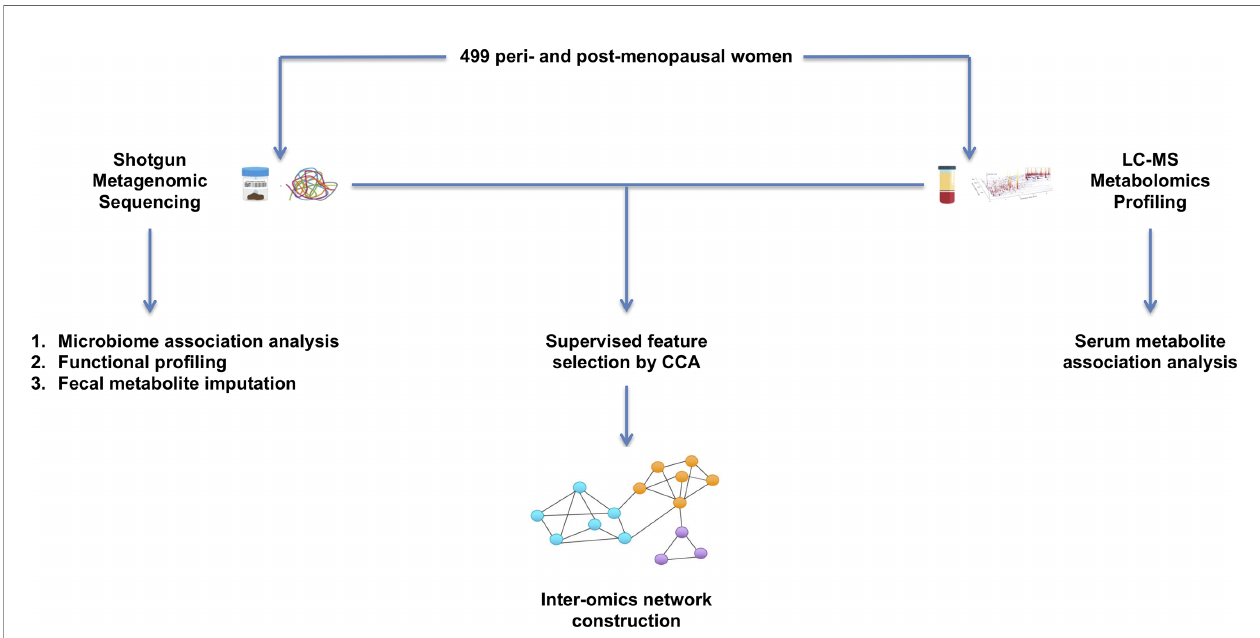
FIGURE 1 | Overview of study work fl ow. 499 peri- and early post-menopausal women provided stool and blood samples for shotgun metagenomic sequencing and untargeted serum metabolomics pro fi ling. Single omics association analyses were fi rst conducted to identify microbes and metabolites that are associated with BMD. The paired microbiome and metabolite pro fi les were then integrated by performing a supervised feature selection with respect to BMD. The selected features were used to conduct inter-omics network analysis to explore the crosstalk between these biological